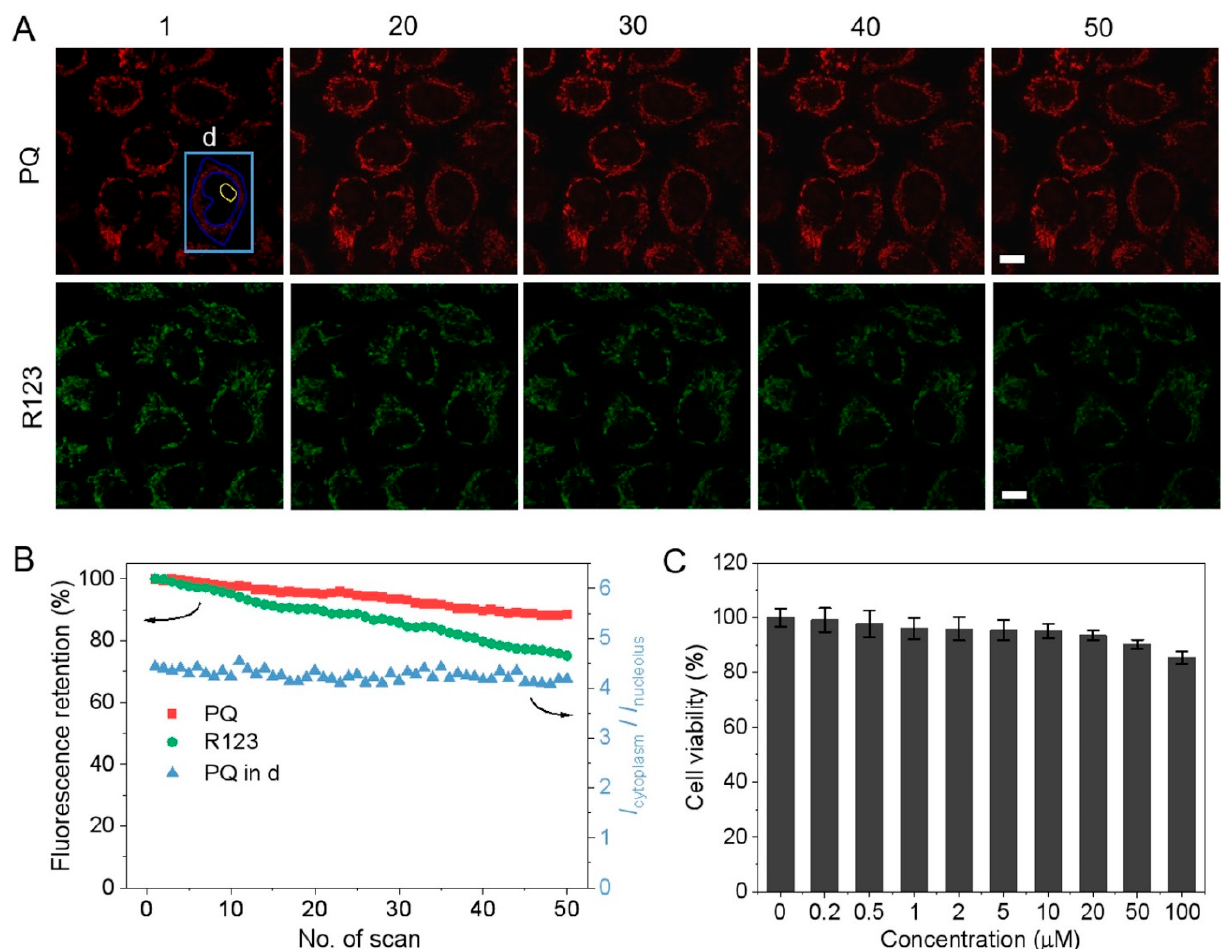
Figure 5. Photostability and cytotoxicity of PQ . ( A ) CLSM images of PQ and R123 in live HeLa cells with continuous scanning ( λ ex / λ em = 488 nm/550–650 nm for PQ , λ ex / λ em = 488 nm/500–550 nm for R123, scale bar: 10 µm); ( B ) mean fluorescence intensity changes of PQ and R123 in live HeLa cells and I cytoplasm / I nucleolus changes of the cell “d” marked in ( A ) with continuous scanning; ( C ) viability of HeLa cells incubated with different concentrations of PQ for 24 h in darkness, the data represent mean ± SD (n = 5). 3.6. Dynamic MMP monitoring in oxidative environments .